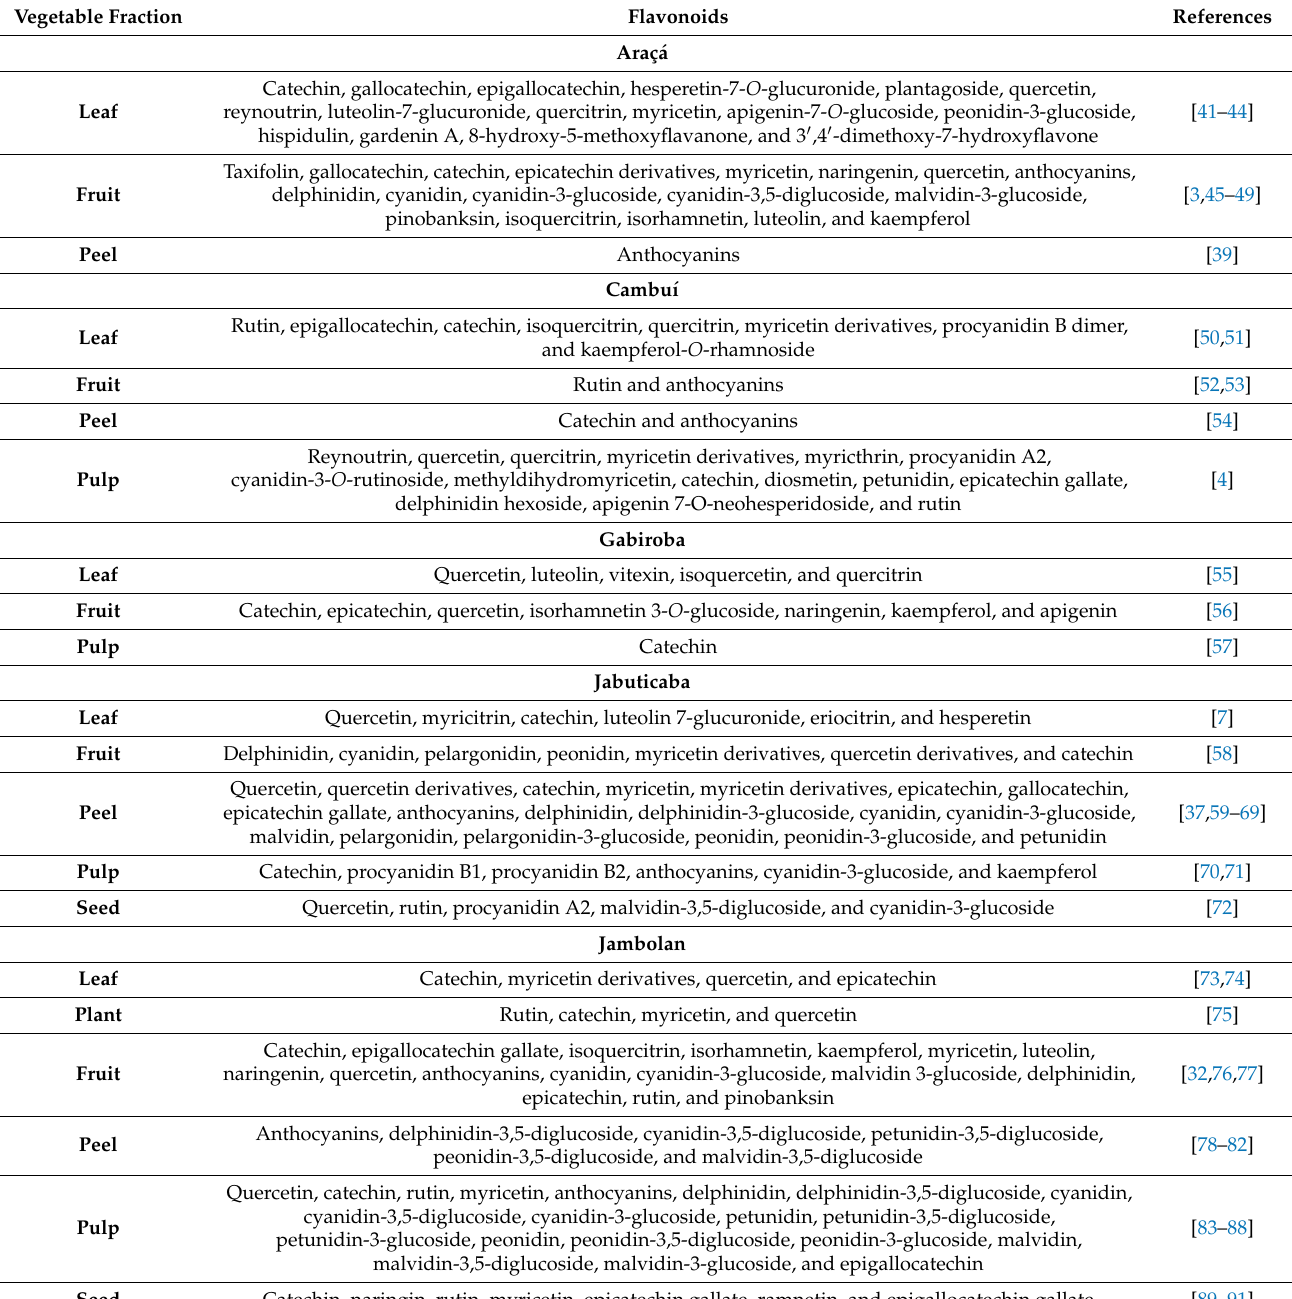
Table 1. Synthesis of selected works with the approach of phytochemical characterization of the different constituent fractions of plants and their